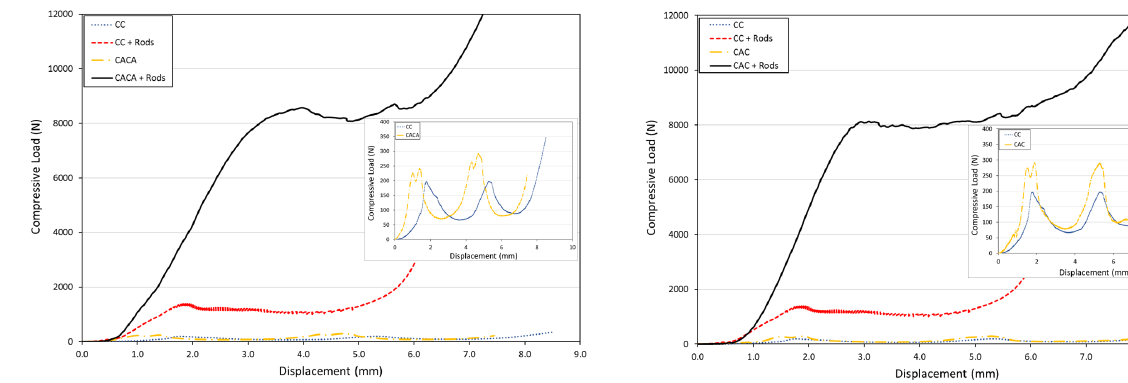
Figure 9: Load-displacement data of panels with two layers of card- board (CC) with and without rods, and two-layers of cardboard and one layer of aluminum in a cardboard-aluminum-cardboard stacking structure (CAC) with and without